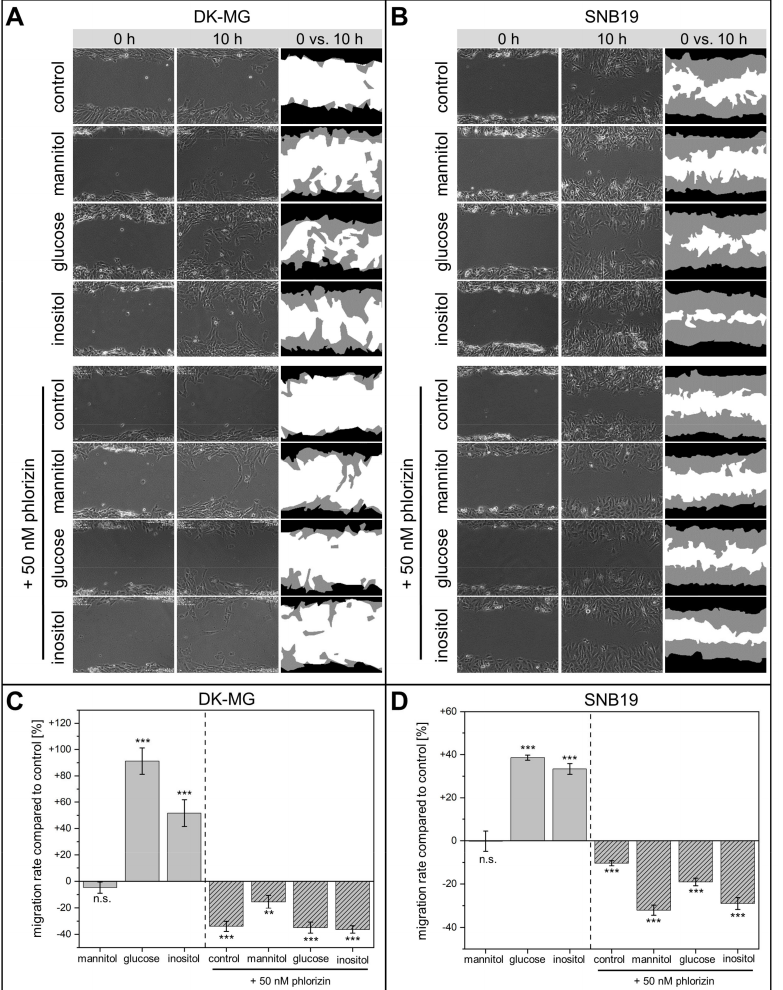
Figure 1. Wound healing assays of DK-MG and SNB19 cells incubated in culture medium supple- mented with either mannitol, glucose or inositol or treated with phlorizin. Representative phase contrast images of wounded DK-MG ( A ) and SNB19 ( B ) cell monolayers shown in the left and middle columns were acquired at 0 and 10 h. The white color in the RHS column of A and B represents the cell-free area, and the black and gray colors denote cell-covered areas at 0 and 10 h, respectively. ( C , D ) Bar graphs summarizing the impact of organic solute-supplemented medium or phlorizin on the wound closure rate of DK-MG ( C ) and SNB19 cells ( D ), expressed in percentage difference to control. Each bar represents the mean ± SE of at least three independent experiments conducted in quadruplicate. “**” and “***” denote p < 0.01 and p < 0.001, respectively; “n.s.” means “not